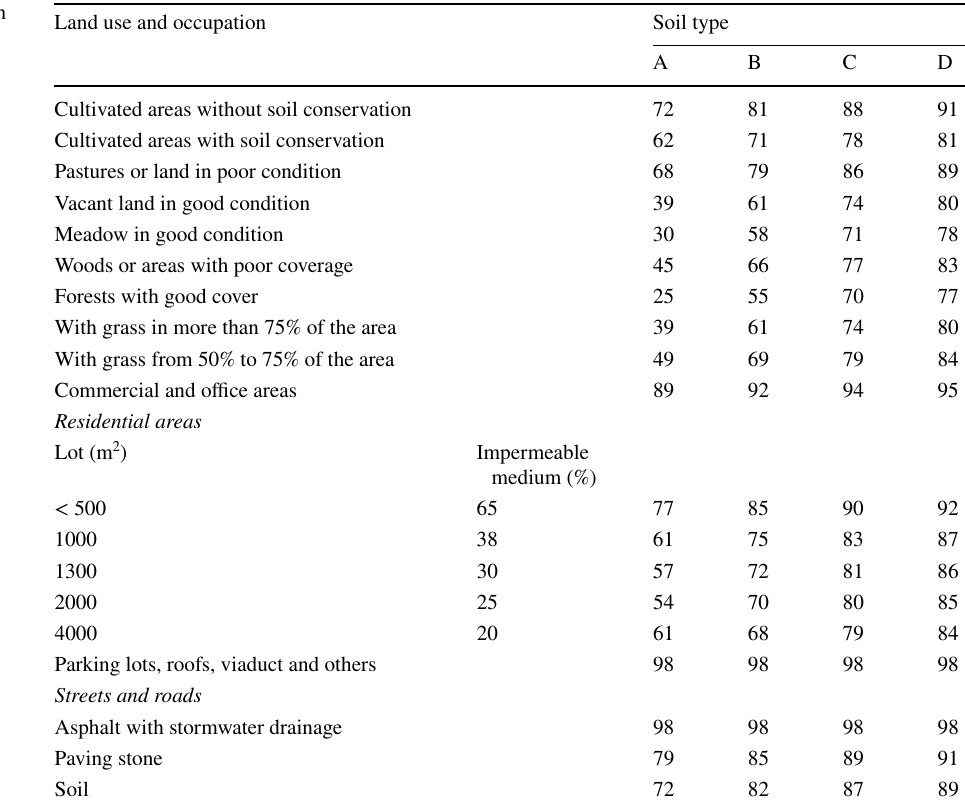
Table 3 Values of CN for urban areas. Adapted from USDA